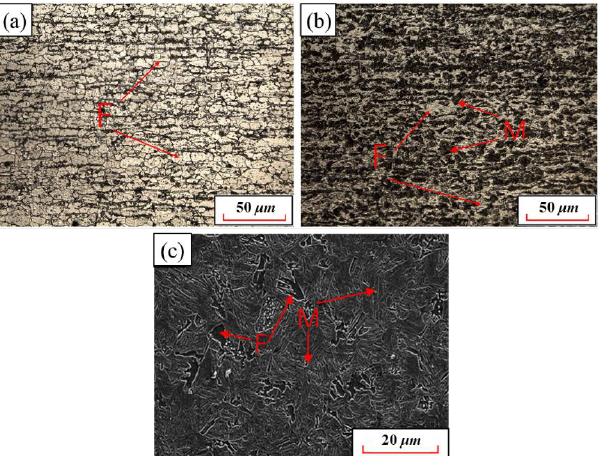
Figure 6. Microstructure of 22MnB5NbV steel after quenching at austenitizing temperature of 780 °C – 840 °C: ( a ) 780 °C; ( b ) 810 °C; ( c ) 840 °C. 840 ◦ C: ( a ) 780 ◦ C; ( b ) 810 ◦ C; ( c ) 840 ◦ C.